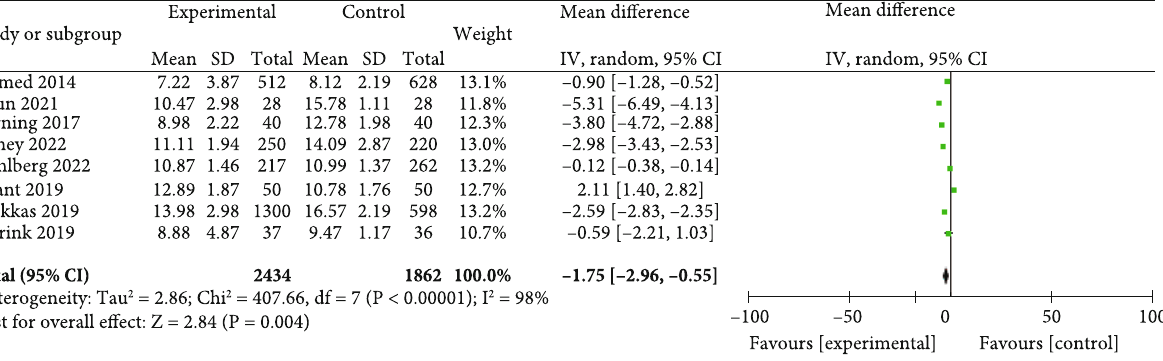
Figure 3: E ffi cacy of high-quality nursing on the recovery time of spontaneous respiration. P < 0 : 00001 , ∗∗∗ . With heterogenity 2.86, Ch i 2 = 407 : 66 , df = 7 , I 2 = 98 % .